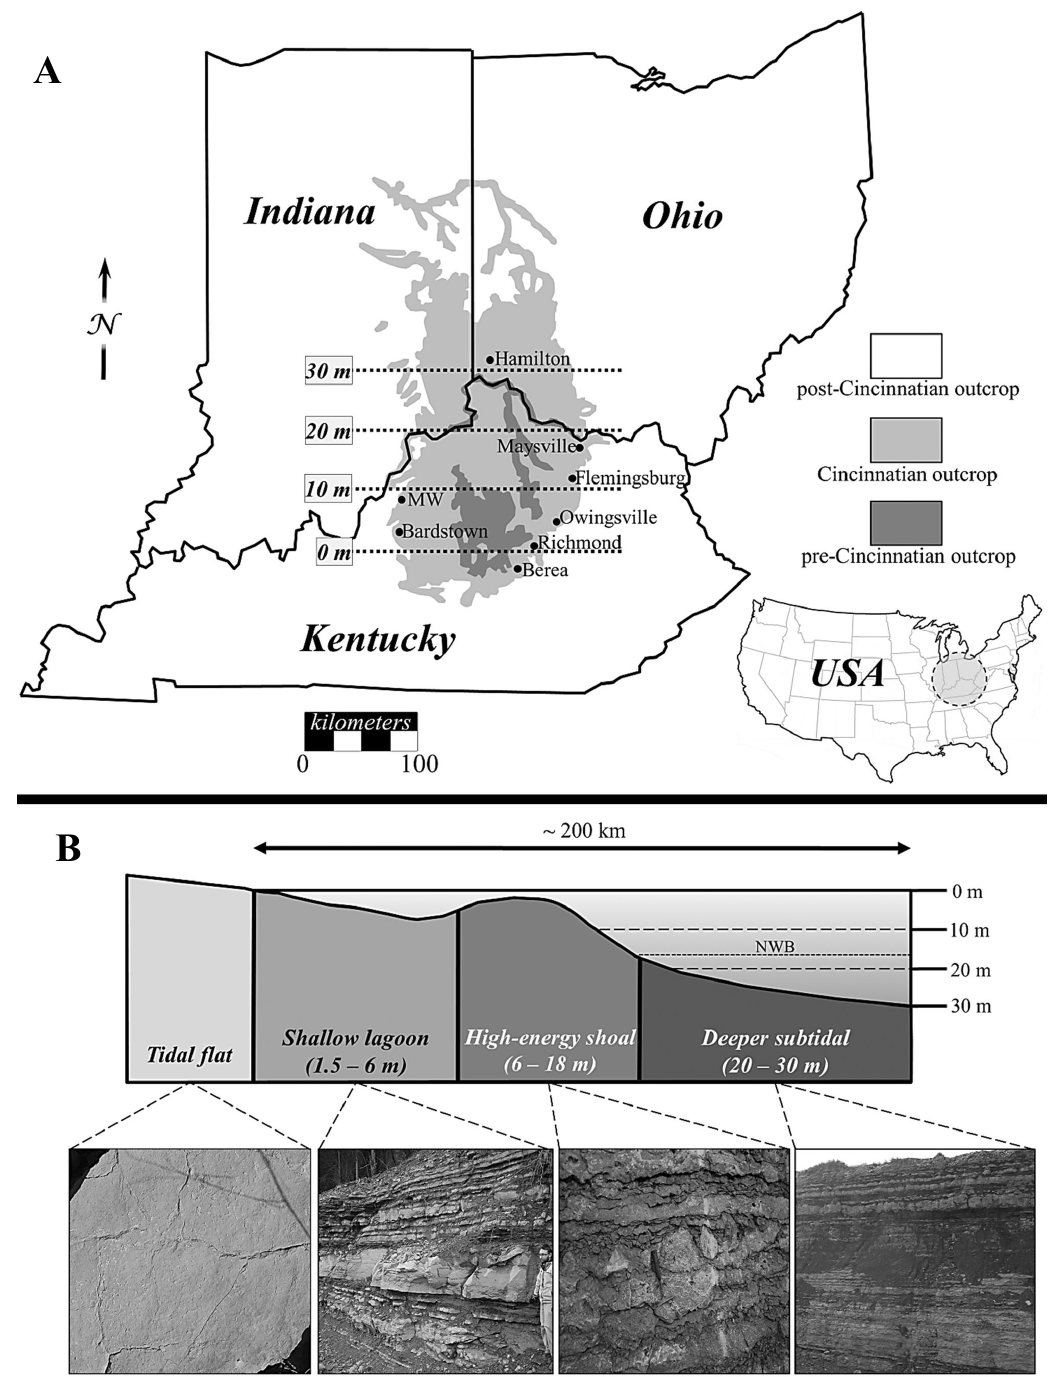
Fig. 1. Paleobathymetry of an Upper Ordovician ramp in the Cincinnati Arch region. A , map showing the distribution of the Ordovician outcrop, localities mentioned in the text and approximate inferred depths below the sediment(cid:150)water interface. The 0-m line marks the northernmost occurrence of desiccation cracks, the 10-m line marks the northernmost occurrence of micritic, pale green mudstones, the 20-m line marks the northernmost occurrence of oncoids and abundant algae. (cid:147)MW(cid:148) = Mt Washington. B , idealized cross-section of the ramp showing lateral lithofacies relationships. Shoal topography is exaggerated, although some areas may have built up locally to a few meters in height. Insets show examples of certain aspects of lithofacies. Note the desiccation cracks in the dolomitic mudstone associated with the tidal flat facies, the carbonate(cid:150)dark shale rhythms in the lagoon facies, the large stromatoporoids in the shoal facies and the muddy wackestones and shelly packstones of the shelf facies. (cid:147)NWB(cid:148) = normal wave